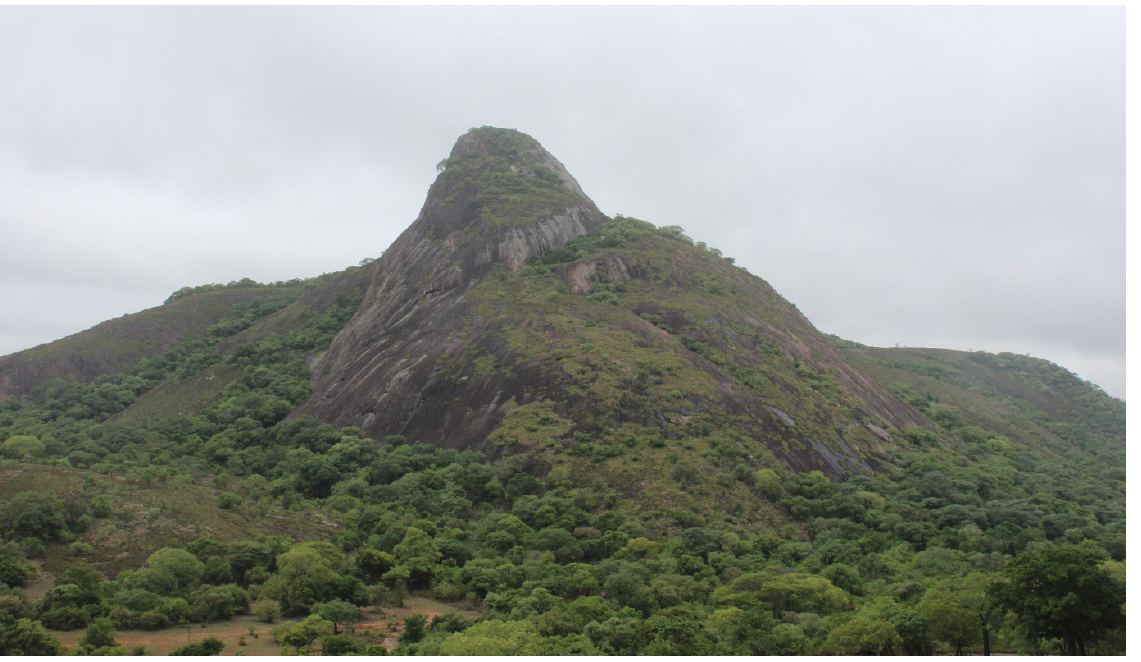
Figure 11. Imbahuru hill, one of the highly revered shrines in Mberengwa that has a long history of use as a venue for rain ‐ imploring rituals.